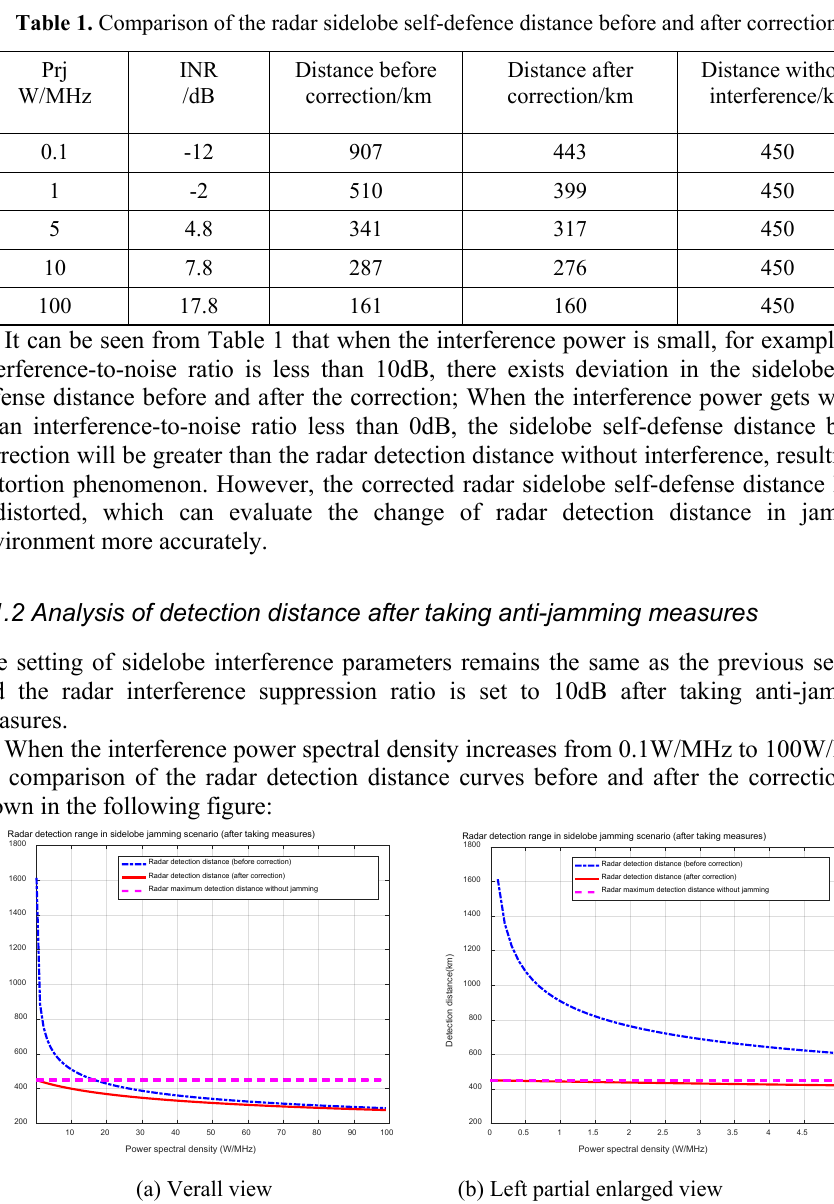
Fig. 2. Comparison of radar detection distance curves after taking anti-jamming